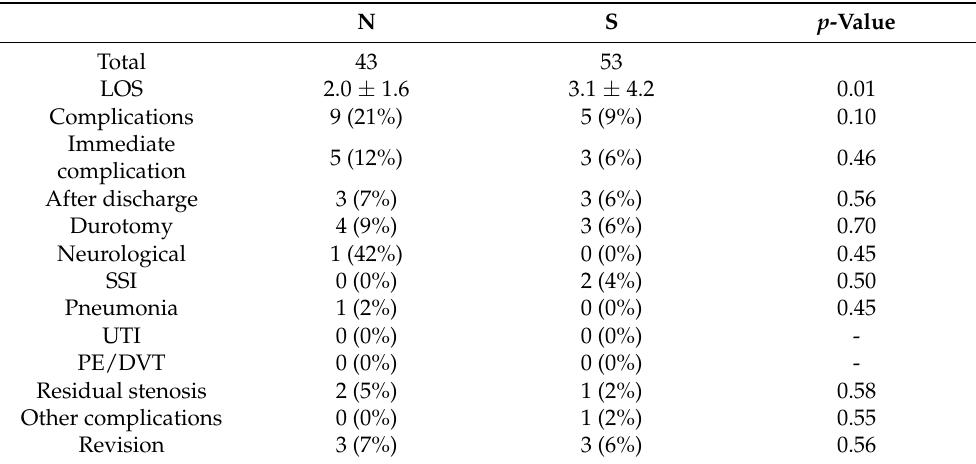
Table 2. Length of hospital stay, postoperative complications, and revisions in both